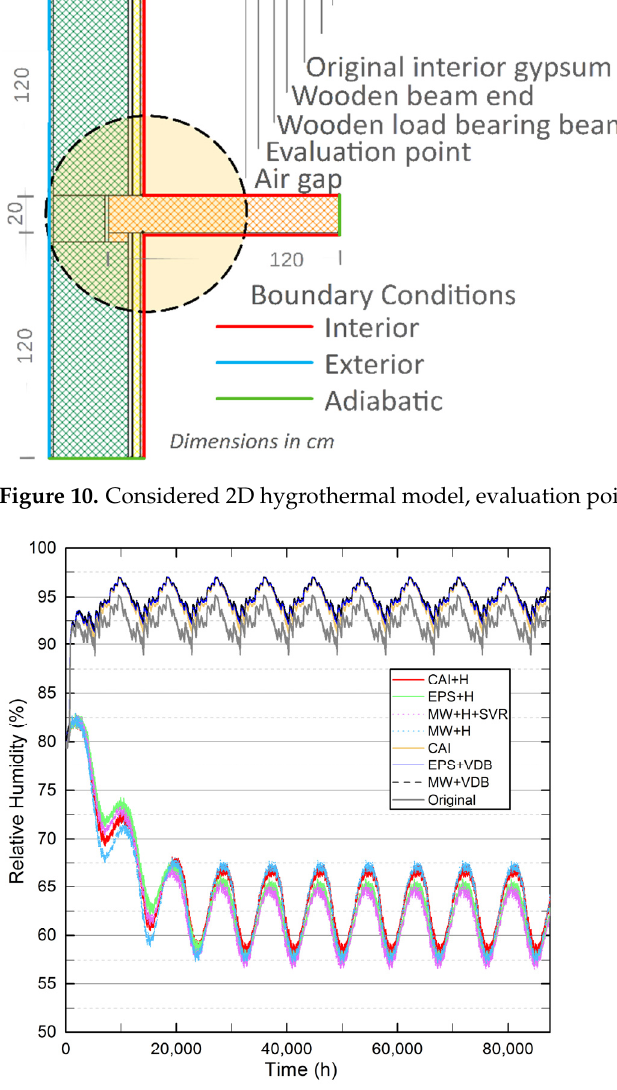
Figure 11. Relative humidity profiles in the wooden beam-end derived from the 2D hygrothermal